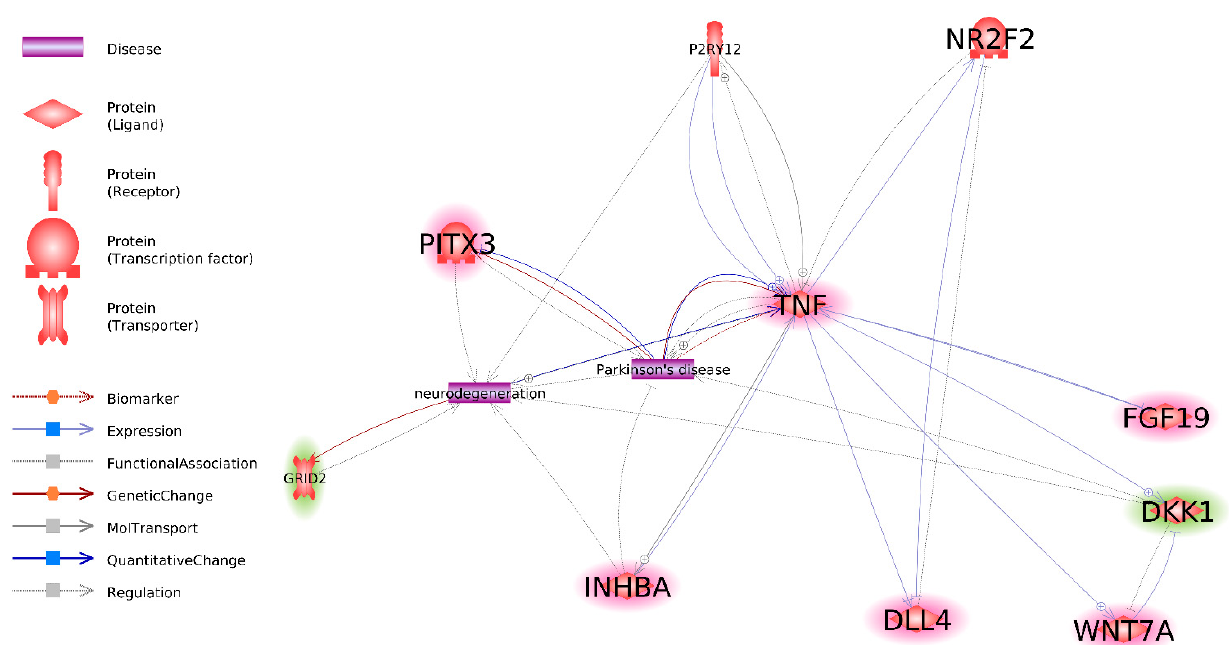
Figure 5. Interaction between most important DEG IPSC and DEG NP based on Pathway Studio data. Genes, overexpressed in NPC derived from twins with PD, as compared to NPC derived from healthy twins are highlighted red. Genes, underexpressed in NPC derived from twins with PD, as compared to NPC derived from healthy twins are highlighted green. Non highlighted genes are underexpressed in IPSC, derived from twins with PD as compared to IPSC, derived from healthy twins.